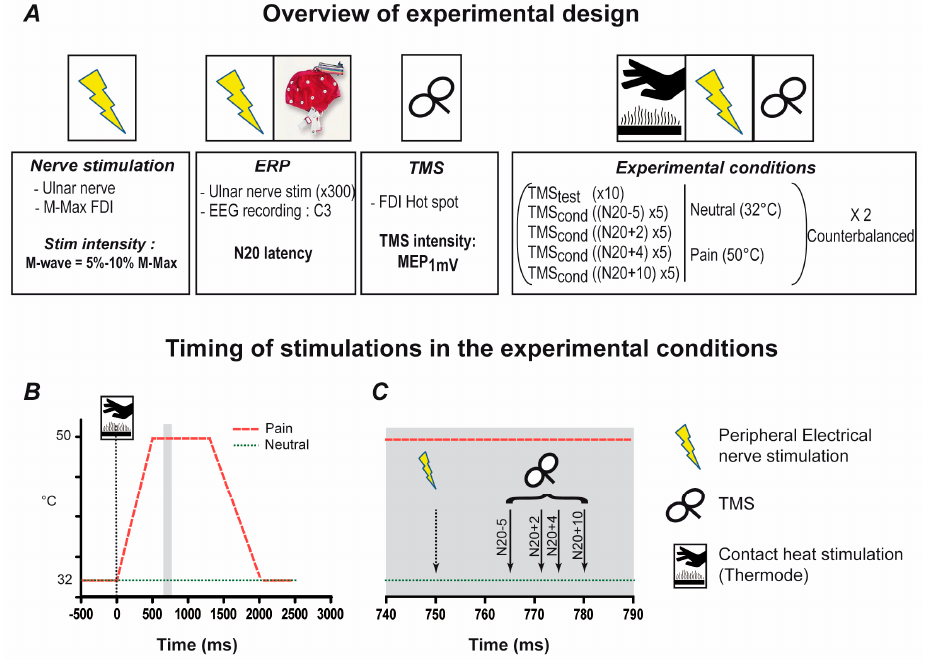
Figure 1. Experimental protocol. ( A ) The experimental design and the timeline of the experiment showing the three steps in the Preparation Phase plus the Experimental Phase; ( B ) The timing of TMS relative to the Heat Pain stimulus (TMS test trials); ( C ) The timing of the TMS relative to the electrical stimulation (TMS cond trials). Note that the shaded area shown in ( C ) is a magnification of the shaded area in ( B ).